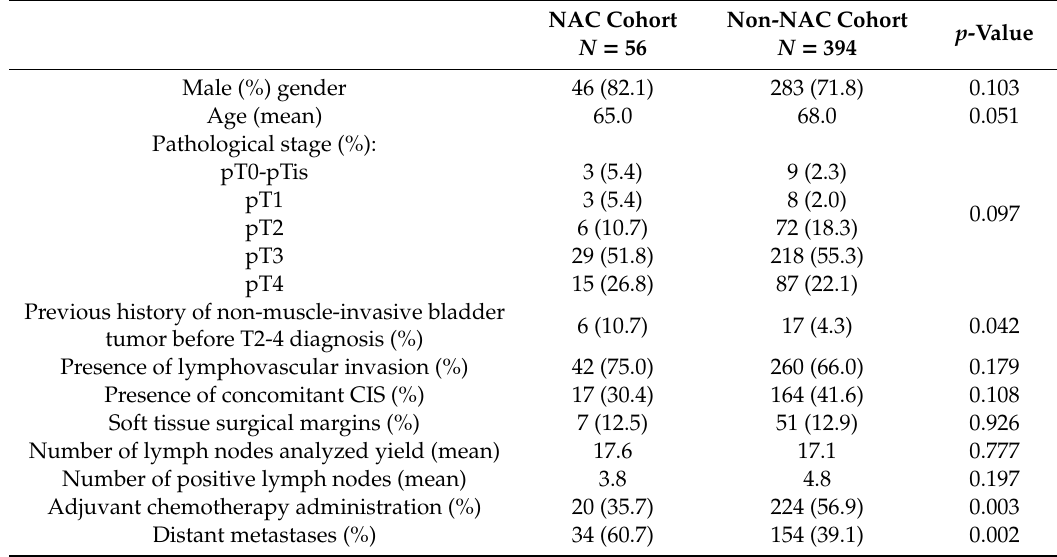
Table 2. Comparisons between neoadjuvant chemotherapy (NAC) and non-NAC